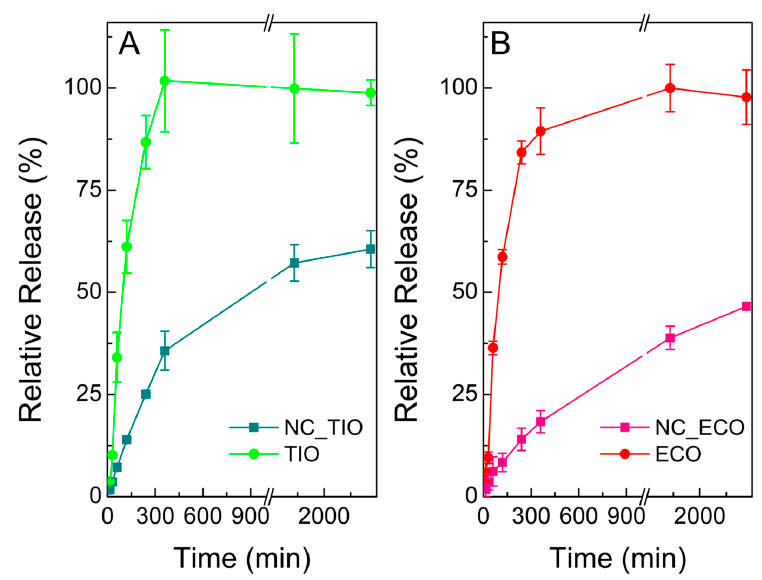
Figure 4. Release curve of ( A ) Tioconazole (TIO) and nanocapsules loaded with TIO (NC_TIO) and ( B ) Econazole (ECO) and nanocapsules loaded with ECO (NC_ECO) in SVF. Data shown are means ± SD ( n = 3).